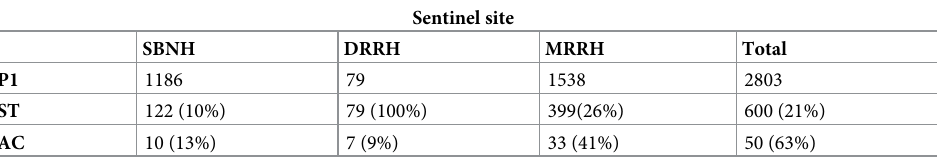
Table 2. The distribution of the SARI patients under the National Influenza Sentinel Surveillance System and the average samples collected per study sentinel sites in Tanzania,